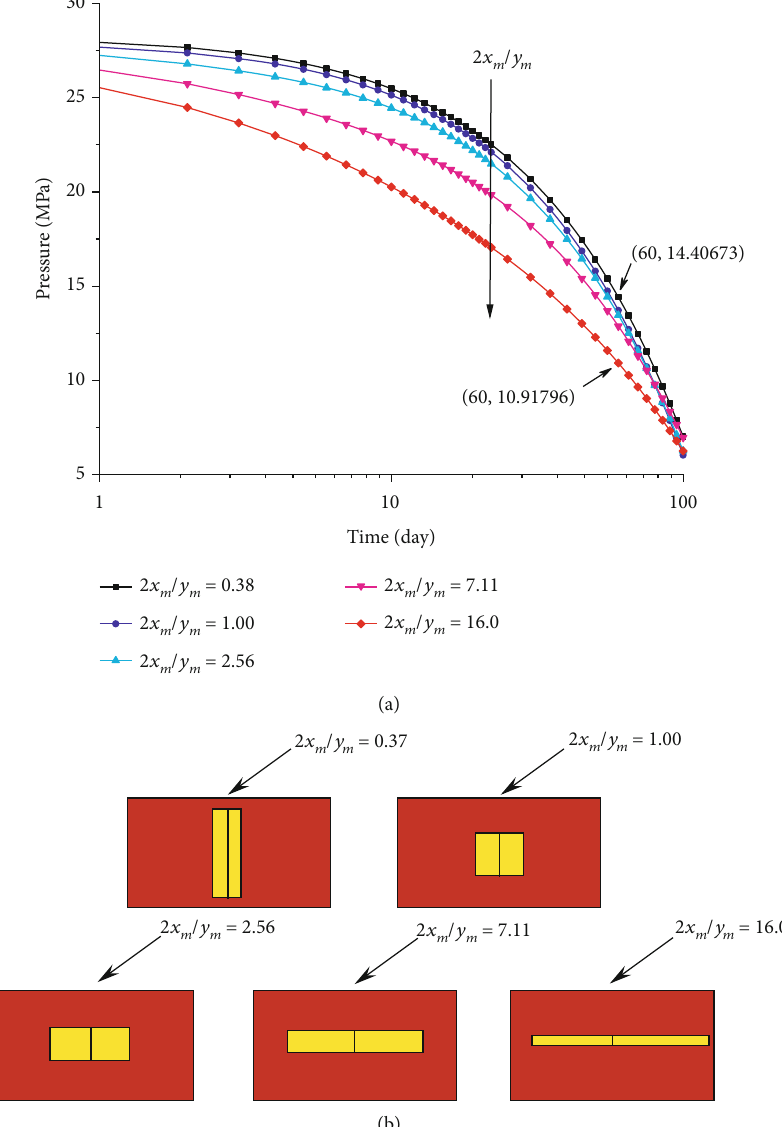
Figure 5: (a) The e ff ect of SRV shape on the fl ow rate and cumulative yield. (b) Schematic diagram of fi ve di ff erent SRV shapes (constant